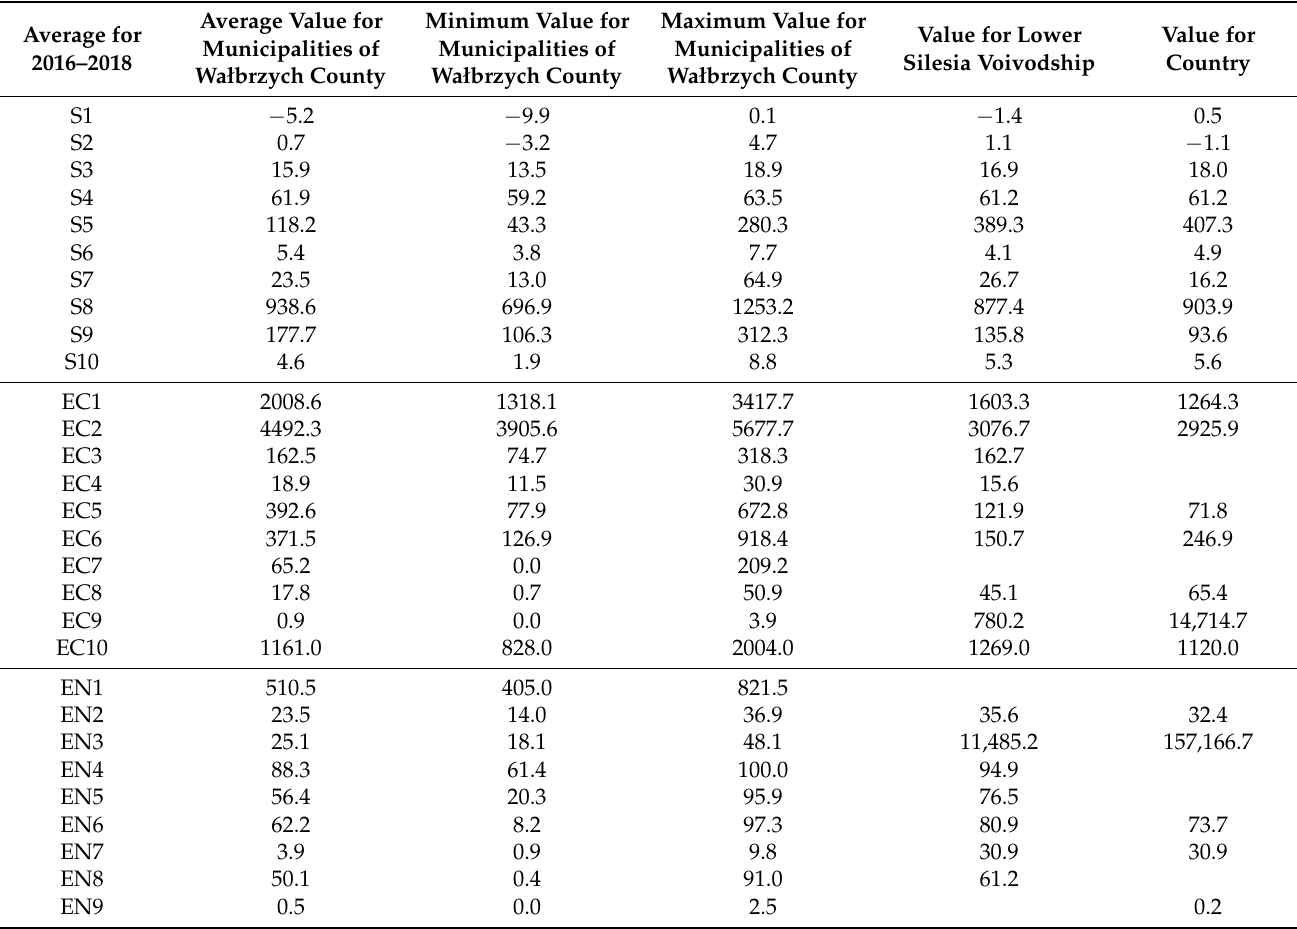
Table 2. Characteristics of variables included in research methods against the background of data from Lower Silesia Voivodship and the entire